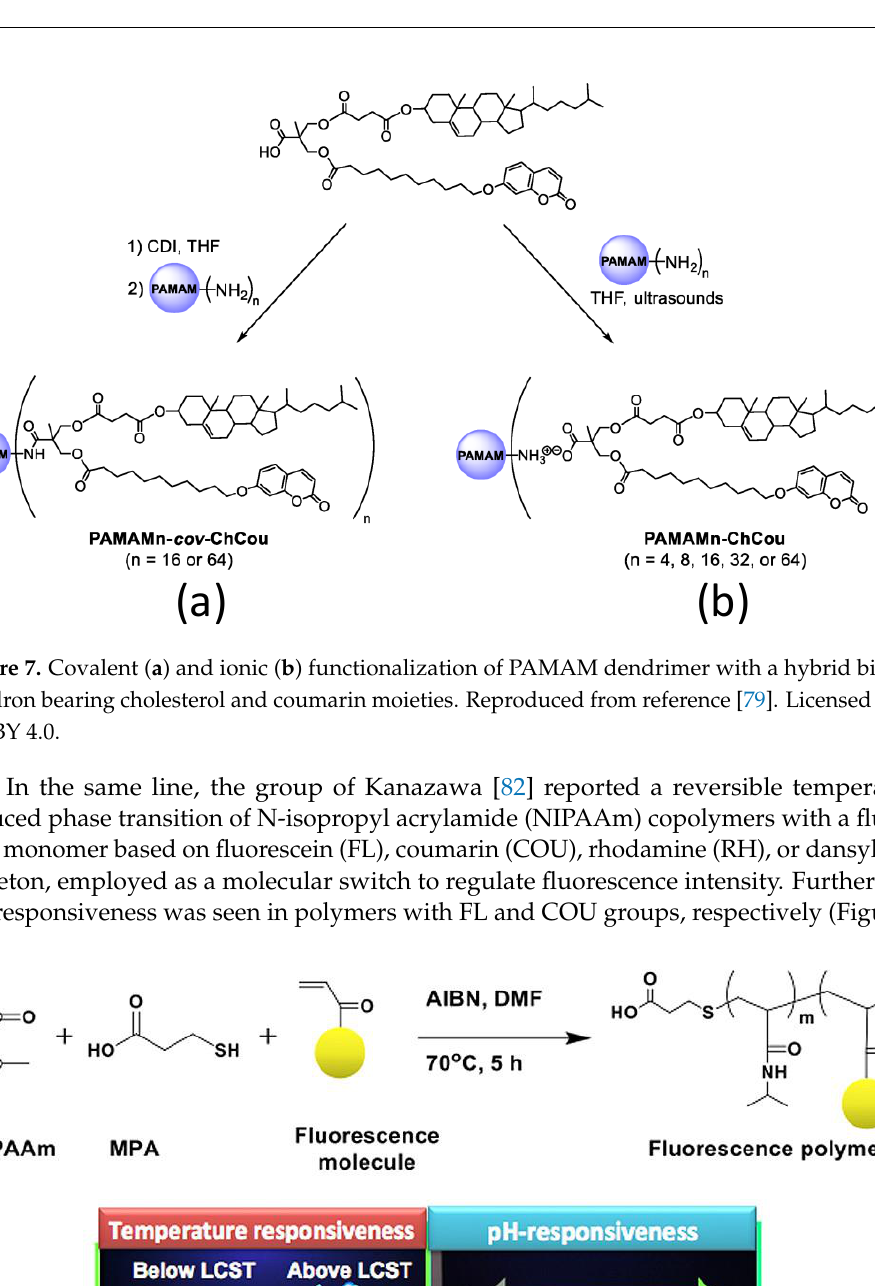
Figure 8. General synthetic scheme for the temperature and pH-responsiveness poly-NIPAAm. Reproduced from reference [82].